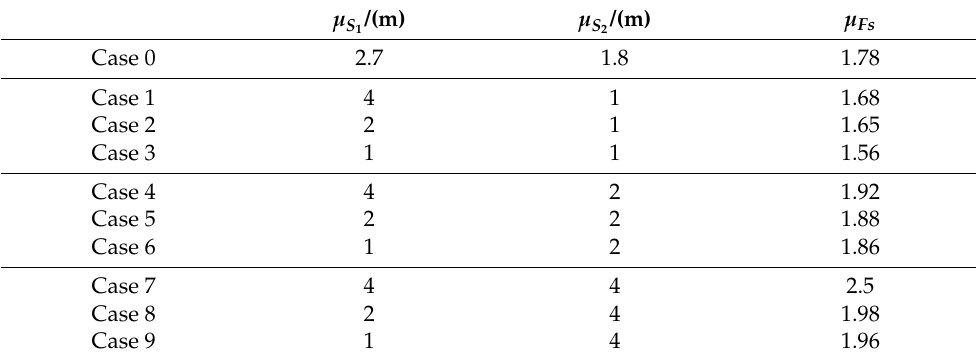
Table 6. Statistical table of the mean spacing and mean